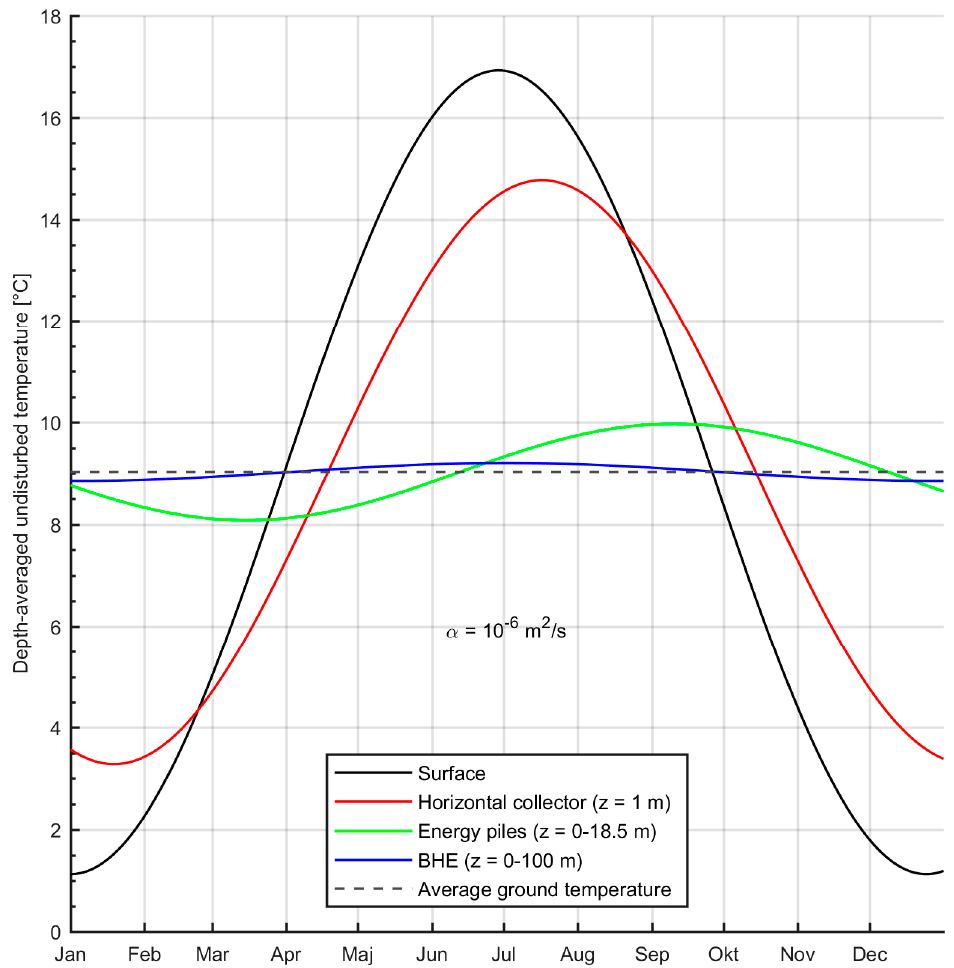
Figure 1. The annual variation in average, undisturbed mean temperature along typical ground heat exchangers (Denmark). Solar radiation is not considered (see Appendix A).